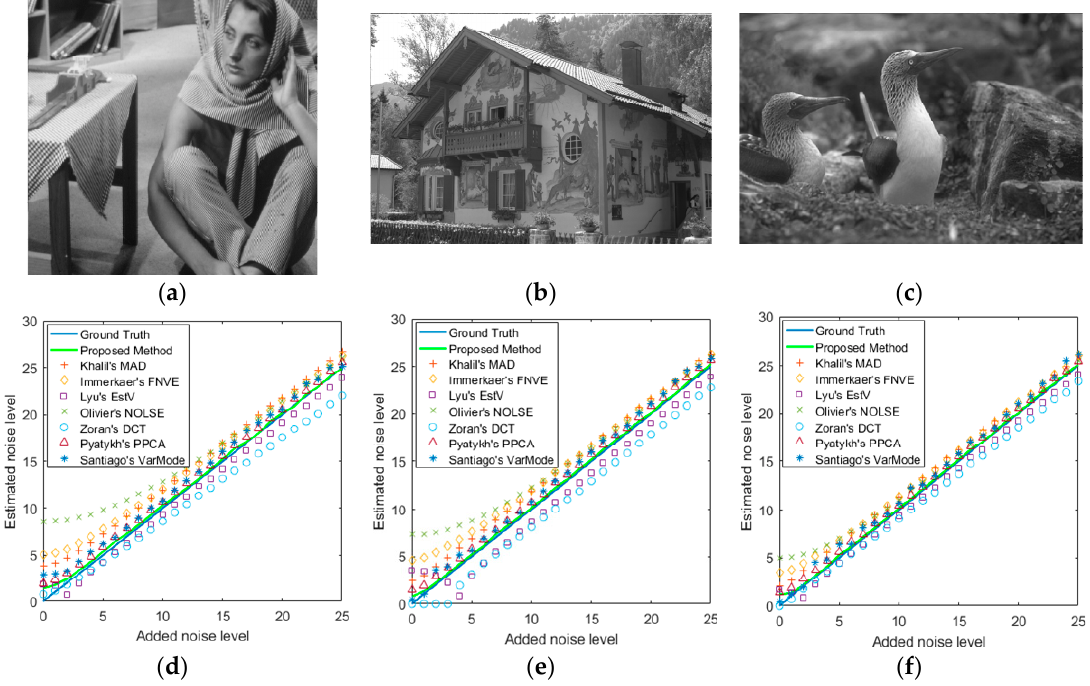
Figure 9. Different AWGN level estimation methods on three images, and the proposed method outperforms other several existing noise estimation methods. ( a – c ) are original images (“Barbara,” “House,” “Birds”); ( d – f ) are their results of noise level estimation respectively.